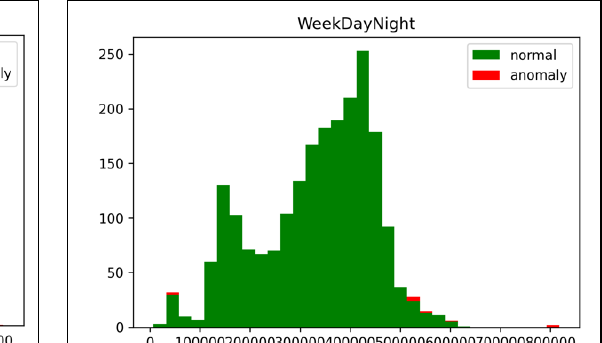
Figure 6. Categorical anomaly detection (weekend, weekday, day, night) for outlier percentage 0.5% (a) iForest (b) OCSVM(c) EE (d) LOF (e) GMM. According to the plot shown in Figure 6, it can be seen that some anomalies points in the different models are similar. However, after further investigating, the detection anomalies value is plotted in the histogram, as shown in Figures 7 to 11. These figures show histograms with anomalies identified as points in red color and normal consumption in green. It demonstrates that at weekend nighttime, around 0.6m active power is considered anomaly white using iForest and GMM. Active power greater than 0.5m is considered an anomaly during the weekend daytime, while using iForest, EE and GMM. By analyzing weekday light time, more significant than ~0.45m active power is regarded as anomalies for iForest, OCSVM, EE, and GMM. The evaluation data presented in Table 2 shows that LOF provides a good detection score. Next, here LOF is compared with other models and finding the common anomalies with LOF. It can clearly understand that the number of anomalies detected by LOF is smaller than other models. However, anomalies point in LOF detected is almost same in different model’s detection output. It can be visualized from Figure 10 LOF model, in the weekday nighttime, active power at 0.8M is considered anomaly as by other models (iForest, OCSVM, EE, and GMM). Moreover, this anomalies detection is not based on active power value, because the system was developed in such a way it will detect seasonal anomalies, rather than anomaly beyond a value of the active power